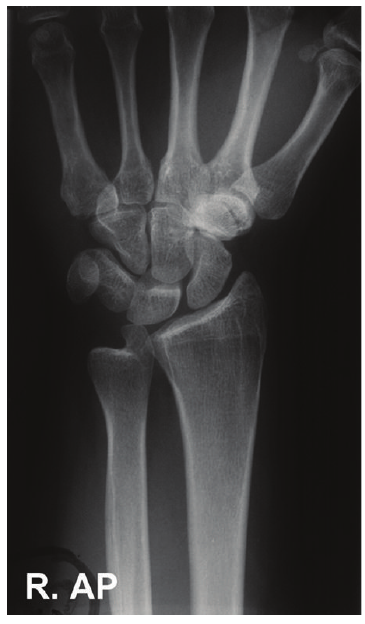
Figure 3: PA radiograph of the injured right wrist demonstrating normal anatomical alignment of the ulnar styloid.